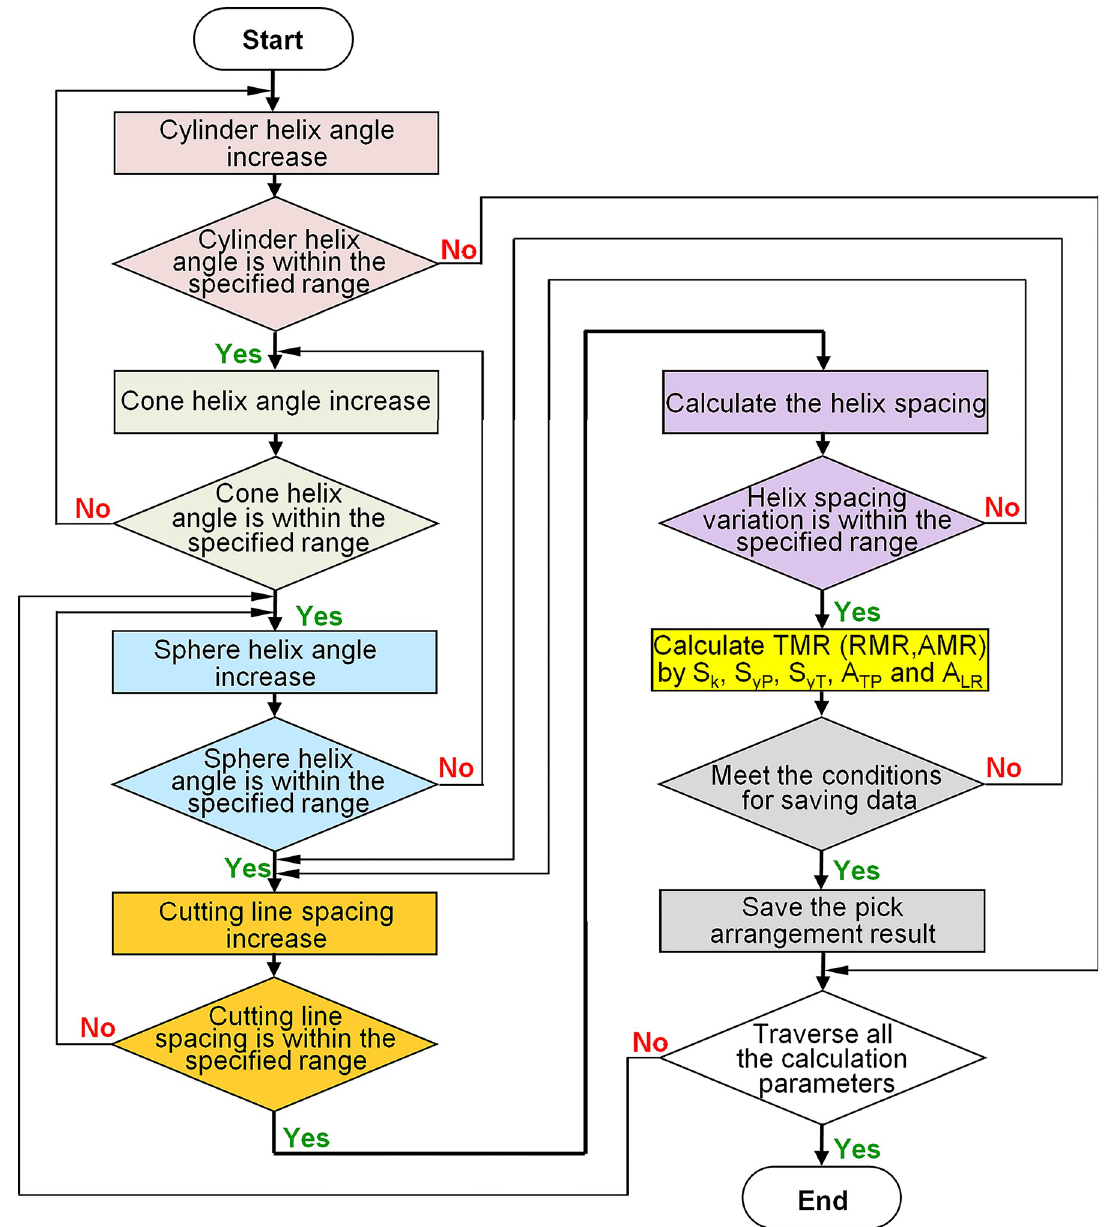
Fig 5. Traversal algorithm block diagram of pick